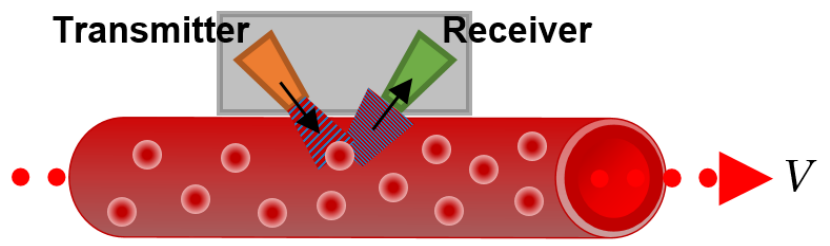
Figure 11. Schematic of a continuous-wave Doppler flowmeter.